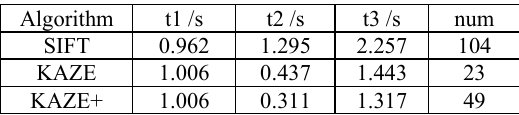
Table 3. The matching result of SPOT5 images(509*512) before and after Wenchuan earthquake